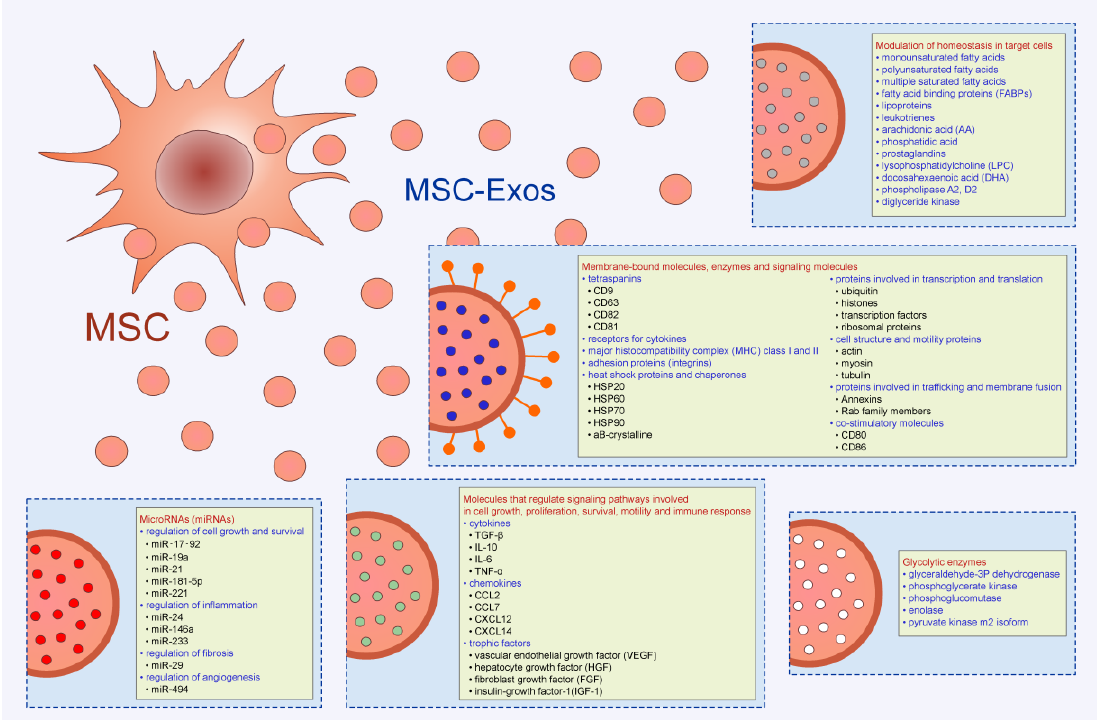
Figure 1. Composition of Mesenchymal stem cells- exosomes (MSC-Exos) and their role in MSC-Exo-mediated biological effects. MSC-Exos contain a large number of biologically active molecules (lipids, proteins (enzymes, cytokines, immunoregulatory proteins, growth factors, and miRNAs) which are responsible for MSC-Exo-based therapeutic effects.